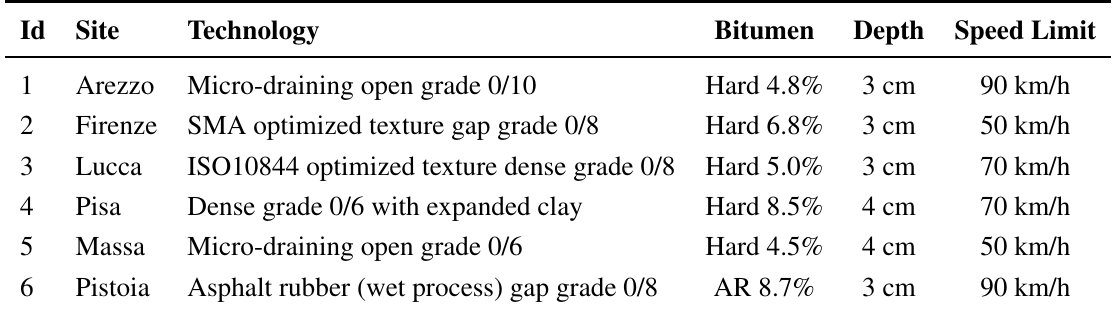
Table 1. Experimental road surfaces details. For more details see Tables 1 and 2 in